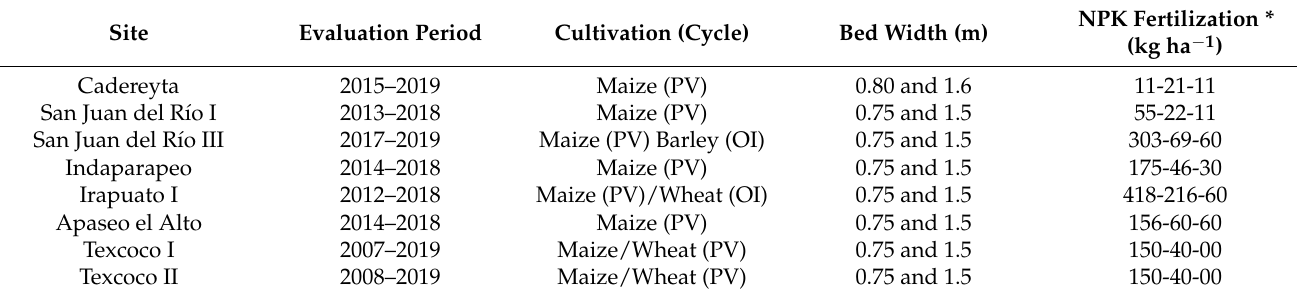
Table 3. Characteristics of the trials and evaluation period at each site.